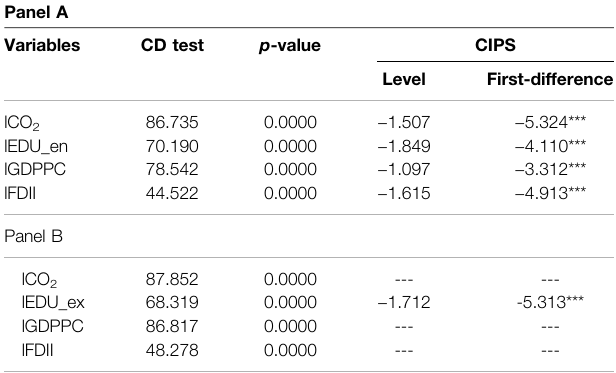
TABLE 3 | Cross-sectional dependence test and CIPS Unit root test results. Panel A